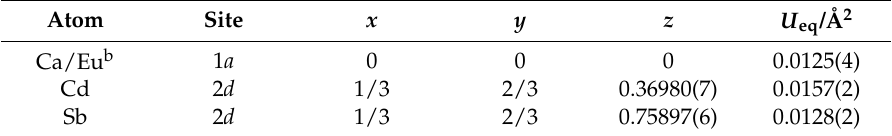
Table 2. Atomic coordinates and equivalent displacement parameters ( U eq a ) for Ca 1 − x Eu x Cd 2 Sb 2 , x = 0.29(1).